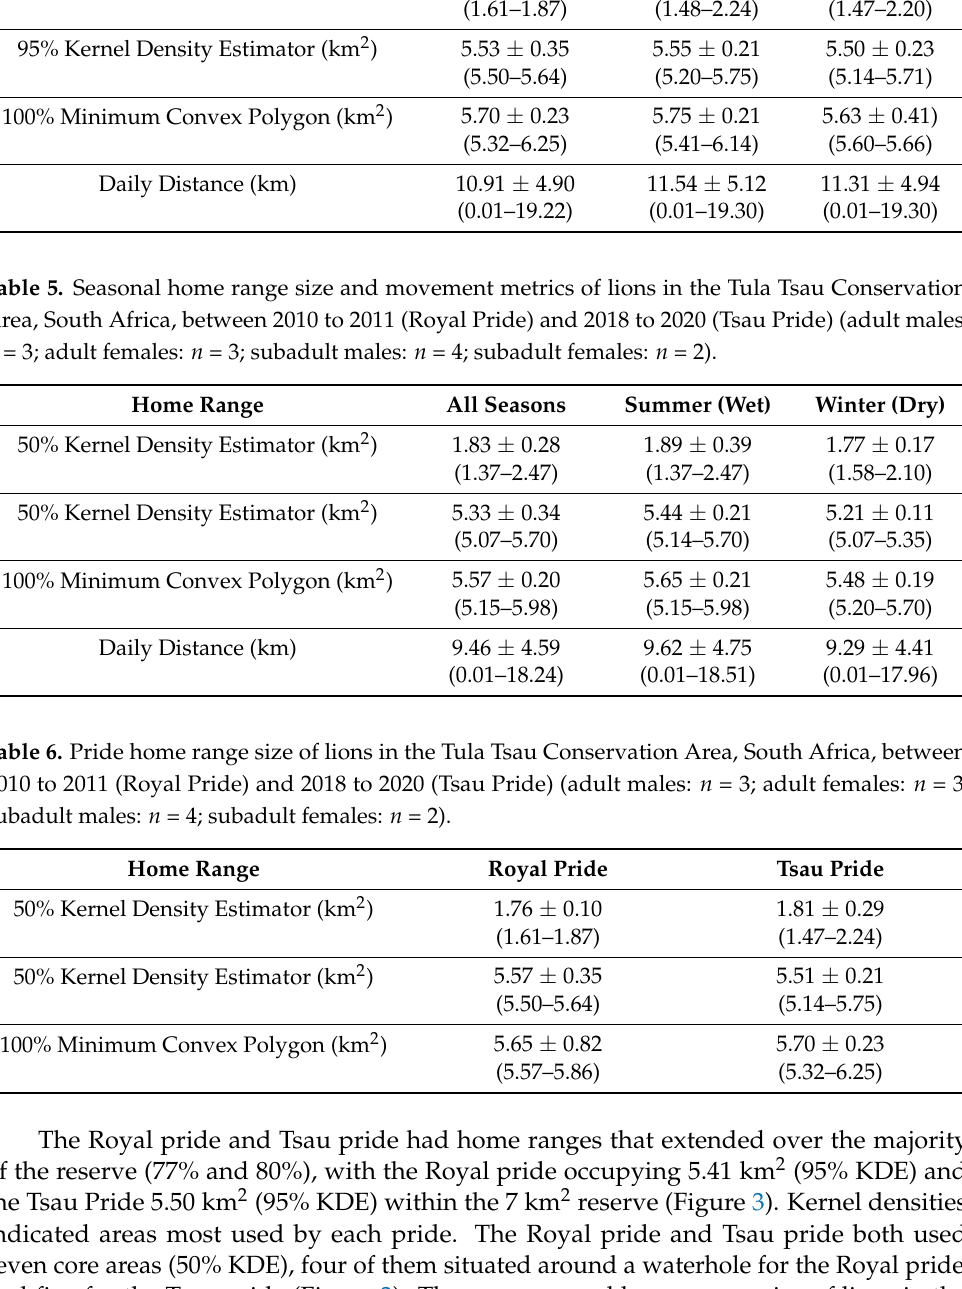
home range. Using 100% of the GPS fixes resulted in a mean annual home range size of 5.70 ± 0.23 km 2 (100% MCP), covering 81% of the Tula Tsau Conservation